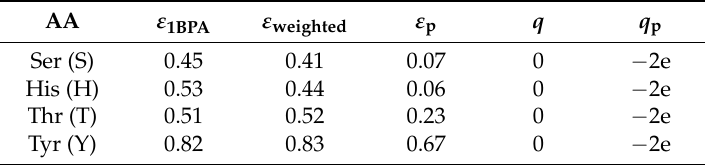
Table 1. Parameters in the 1BPA forcefield for phosphorylated amino acids. Note that: ε 1BPA and ε weighted are the normalized hydrophobicity values (between 0 and 1) from the 1BPA model [35] and the weighted average scheme (see Section 4) for the amino acids in their native state, respectively; ε p is the hydrophobicity of the phosphorylated amino acid; and q and q p denote the charge of the amino acids in their native and phosphorylated conditions,